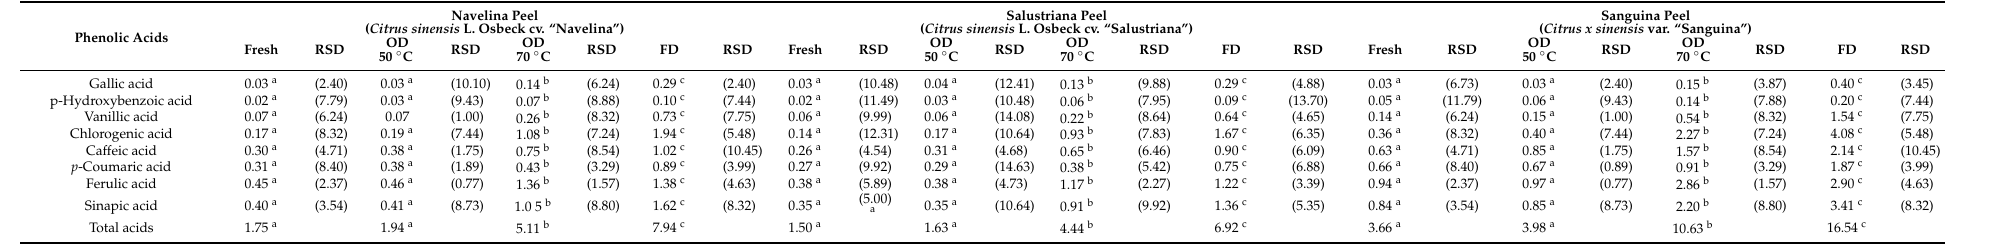
Table 2. Mean values of phenolic acids (mg. g − 1 DW) and relative standard deviation (RSD) in fresh extracts, oven-dried at 50 ◦ C (OD-50 ◦ C), oven-dried at 70 ◦ C (OD-70 ◦ C), and freeze-dried